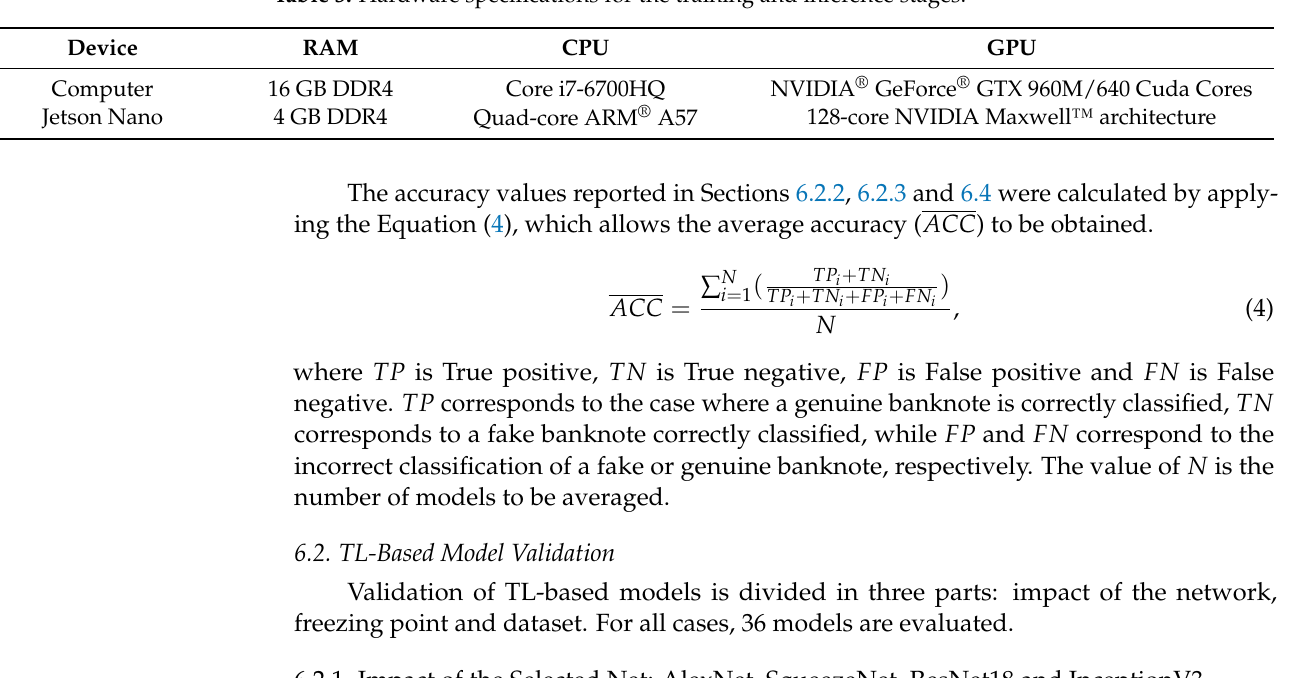
Table 3. Hardware specifications for the training and inference